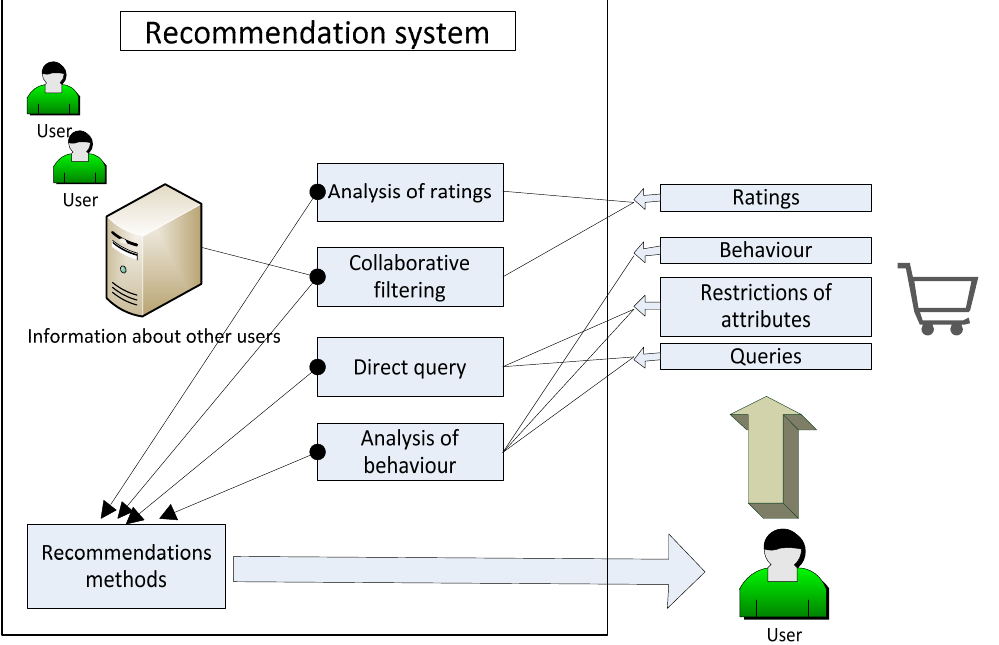
Figure 1. Recommendation systems.